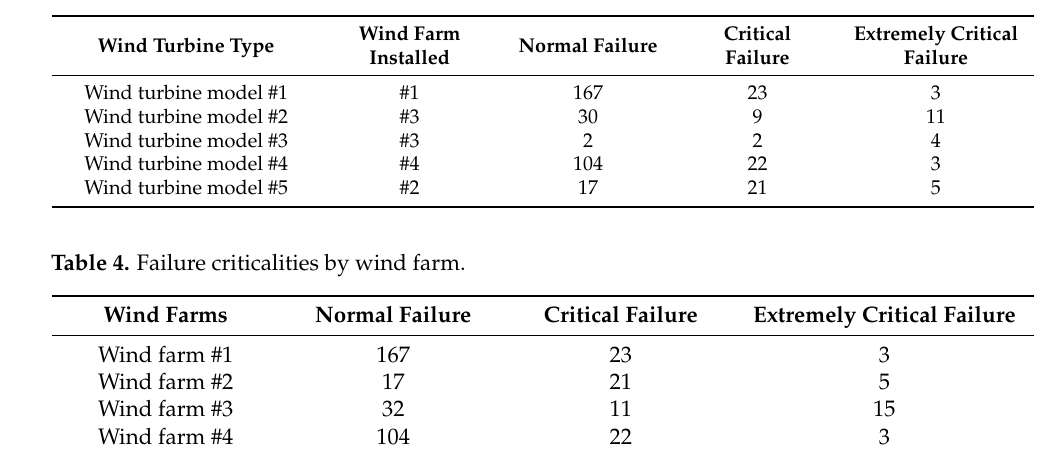
Table 3. Failure criticalities by type of wind turbine.